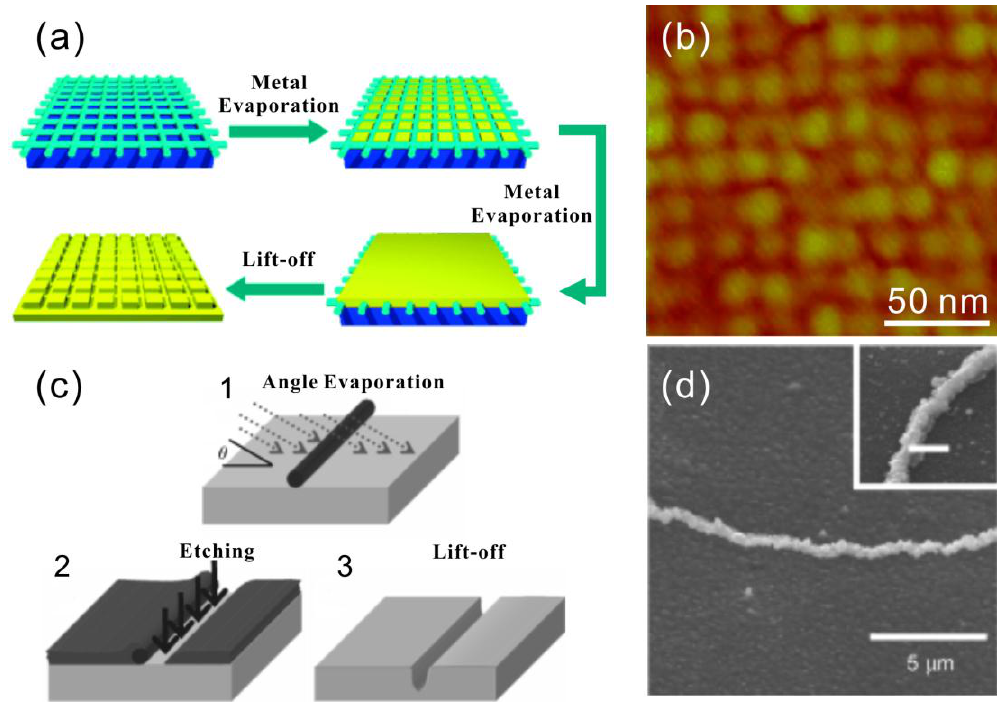
Figure 6. ( a ) Method to transfer the negative pattern from the DNA nano-grid to a gold surface [100]; ( b ) AFM image of the gold surface with the negative square grid from DNA assembly [100]; ( c ) by using a dsDNA as a mask in an angled evaporation, an open area is formed on the evaporated film, which can be further utilized as an etching mask [101]; ( d ) silver nanowire grown in the etched trench [101]. (a,b) are reproduced with permission from [100]. Copyright John Wiley and Sons, 2004; (c,d) are reproduced with permission from [101]. Copyright John Wiley and Sons, 2007.